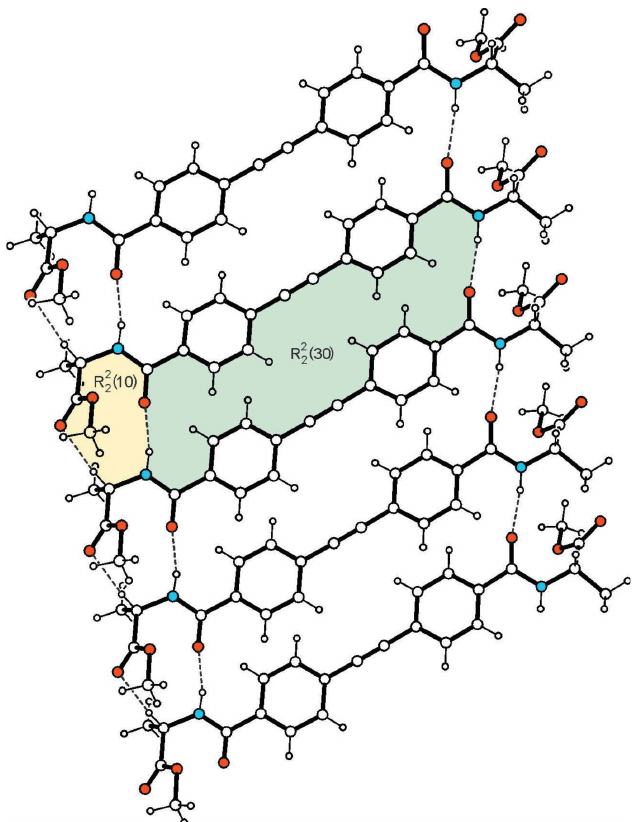
Figure 2 Structure of the molecular ribbon including the mode of intermolecular bonding in the crystal of the title compound. Dashed lines represent hydrogen bonds (Table 1). Ring motifs [graph sets R 2 marked by colour highlighting.